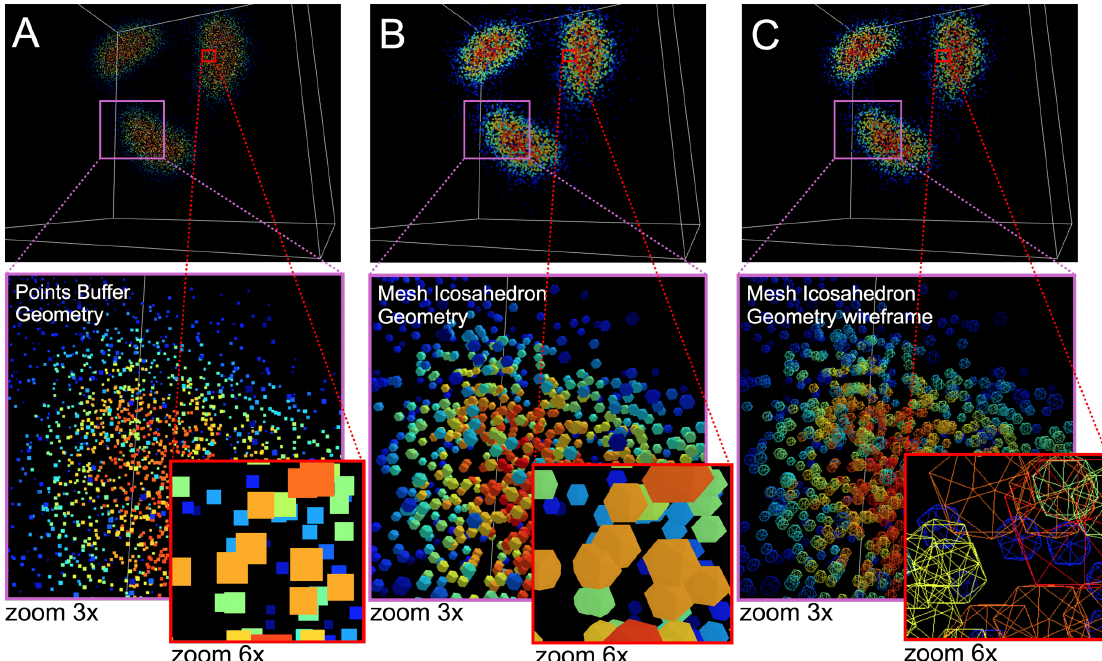
Figure 5. Object representation comparisons for the same wavefunction example. The subfigures illustrate: ( A ) the point buffer primitives, ( B ) the mesh icosahedron geometry primitives, and ( C ) the wireframe mesh icosahedron primitives. Each representation is shown with 3 × and 6 × zoom for clarity (bottom